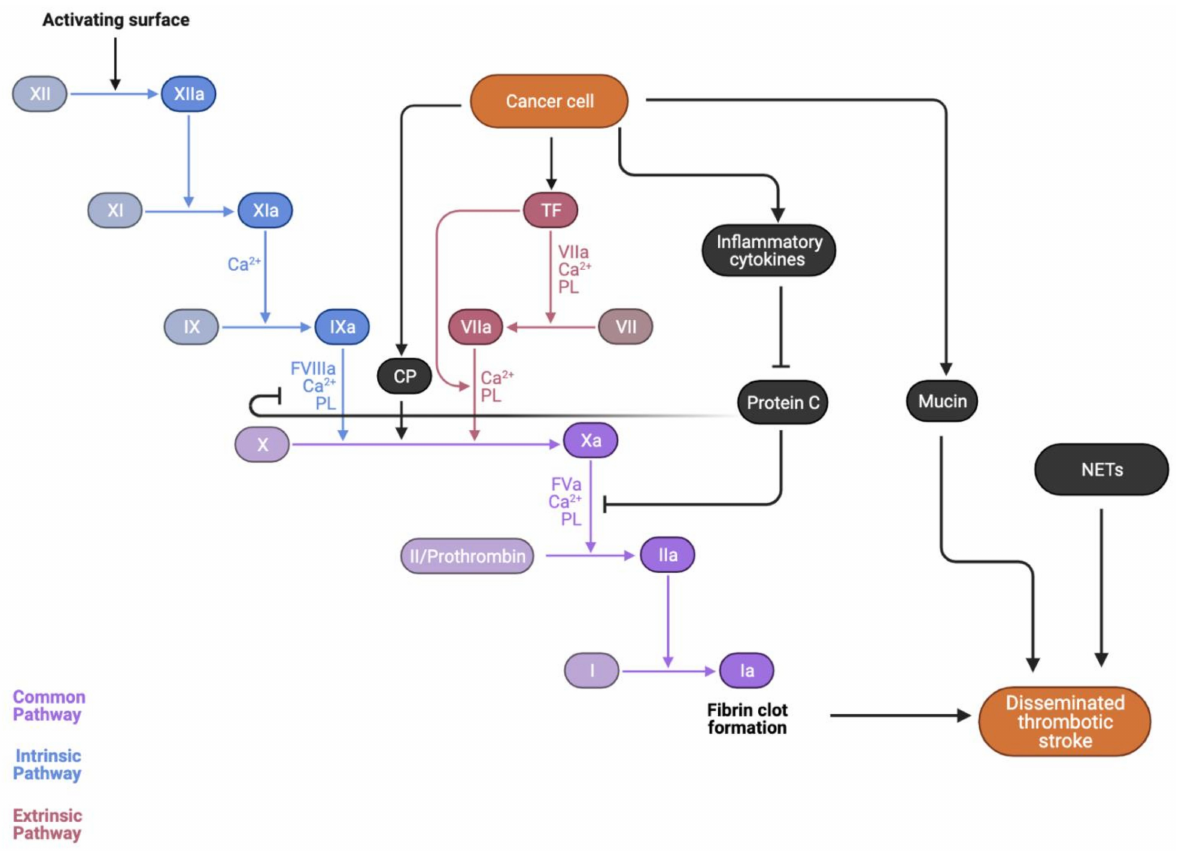
Figure 2. Cancer-induced hypercoagulability on a molecular level. Impact of cancer on the coag- ulation cascade. Inflammatory cytokines such as TNF-a, IL-1, and IL-6 induce endothelial cells, monocytes, and cancer cells to express tissue factor (TF), exerting a parallel action to potentiate the coagulation cascade. Protein C, which regulates Factor VIIIa and Factor Va (cofactors in the activation of Factor X and prothrombin), is inhibited by these cytokines. TF binds to Factor VII, potentiating the coagulation cascade by proteolytically activating Factor IX and Factor X, thus leading to the formation of thromboses and subsequent stroke. CP, a cysteine protease, is released in most malignancies and directly cleaves. Factor X → Xa independently of FVII, resulting in thrombin generation. Mucin is a potent procoagulant that directly activates prothrombin into thrombin, mostly secreted by adenocarcinomas. Abbreviations: CP: cancer procoagulant; TF: tissue factor; PL: phos- pholipids; NETs: neutrophil extracellular trap; TNF: tumor necrosis factor; IL: interleukin; and CP: cancer